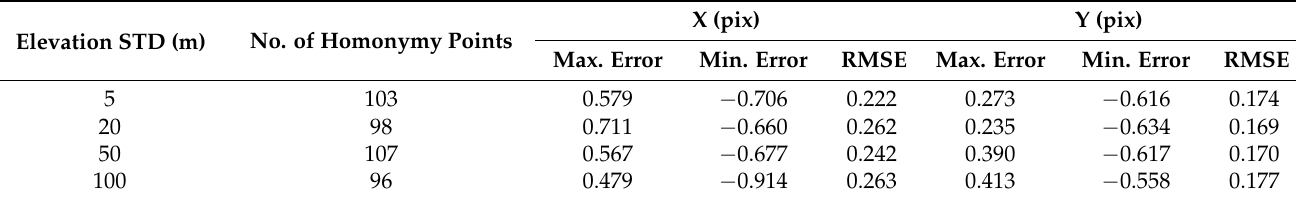
Table 13. Stitching error of EA-unstable-2 (left-middle image).